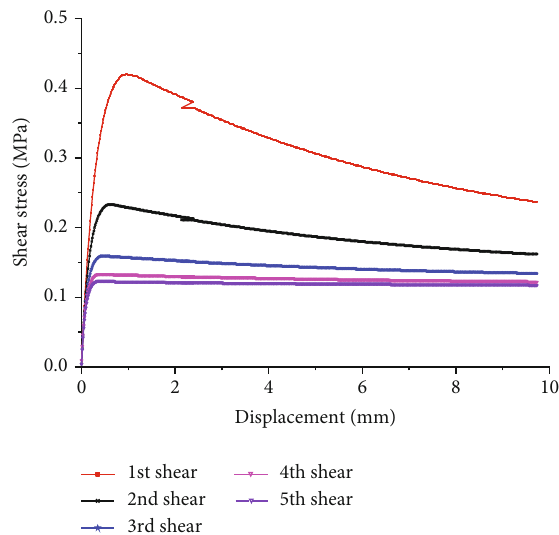
Figure 13: Discrete element simulation results.